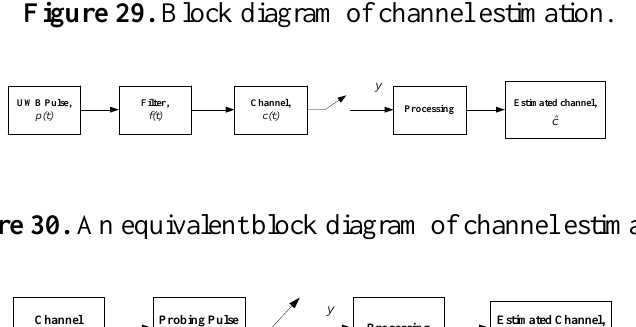
Figure 29. Block diagram of channel estimation.